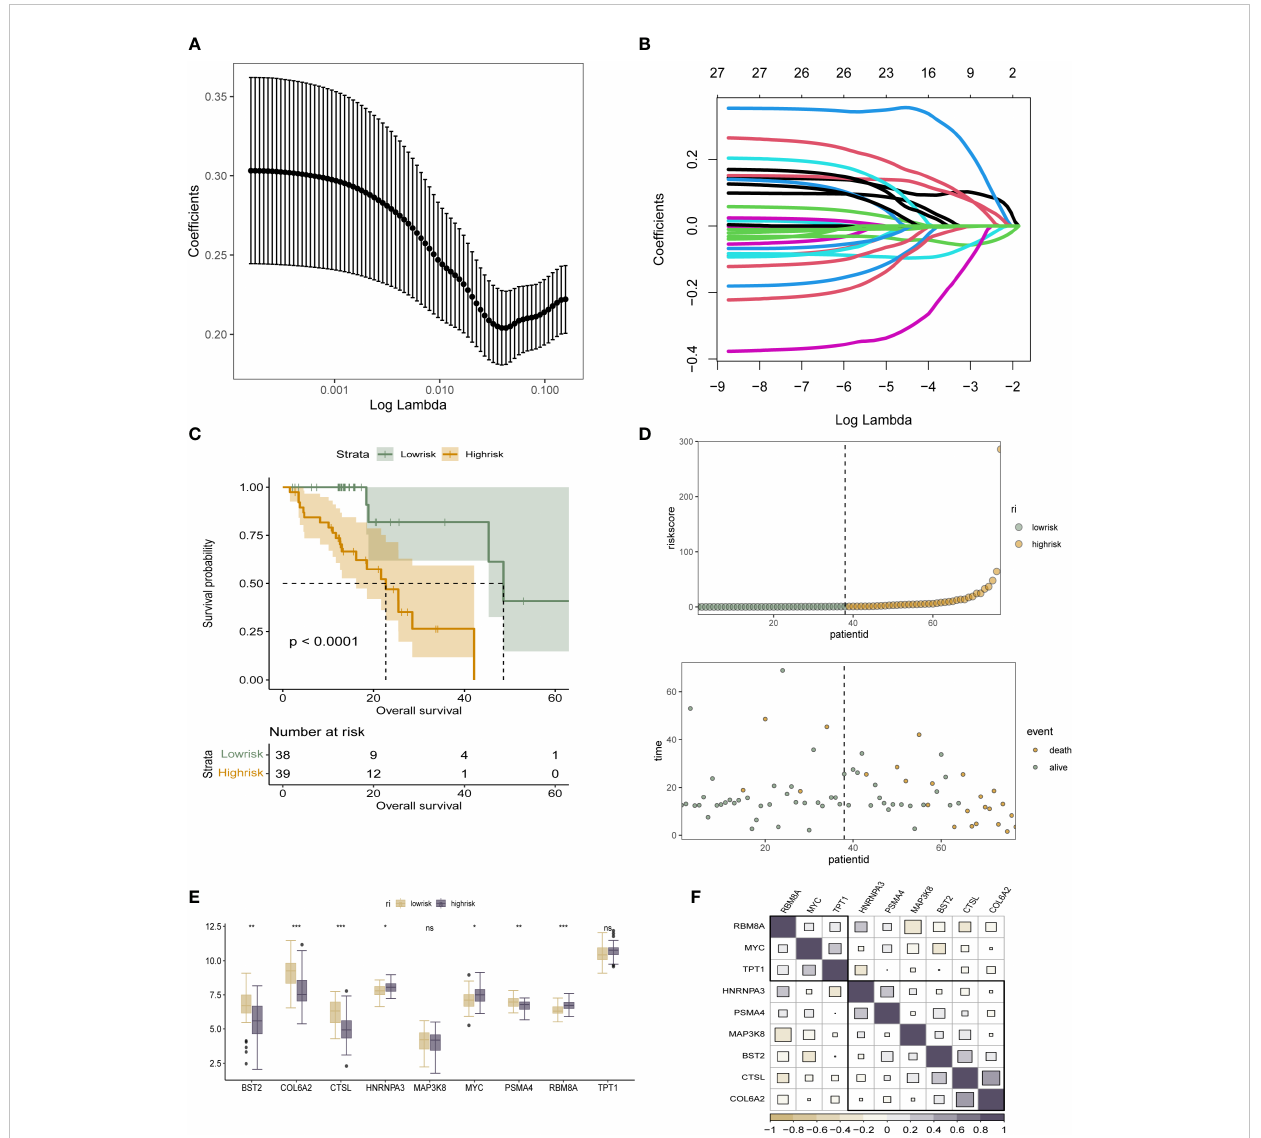
FIGURE 3 Acquisition of survival-associated differential genes for m6A epigenetic inheritance and prognostic model construction (A, B) . LASSO regression process for screening survival-related prognostic genes from 29 m6A epigenetically related differential genes; (C) . K-M analysis reveals the prognostic strati fi cation ability of the constructed m6A epigenetically related riskscore for patients in the high-risk and low-risk groups, respectively; (D) . Dotted line and scatter plots reveal the different riskscore of survival time and survival status of ESCC patients, from left to right representing the high and low variation of riskscore, respectively, and scatter colours representing survival and death status; (E) . Box line plot revealing the expression distribution of 10 risk genes in the low- and high-risk groups of the 6A epigenetic patient population; (F) . Expression correlation plot of the 10 risk genes constituting the riskscore. * means <0.05, ** means <0.01, *** means <0.001, ns means